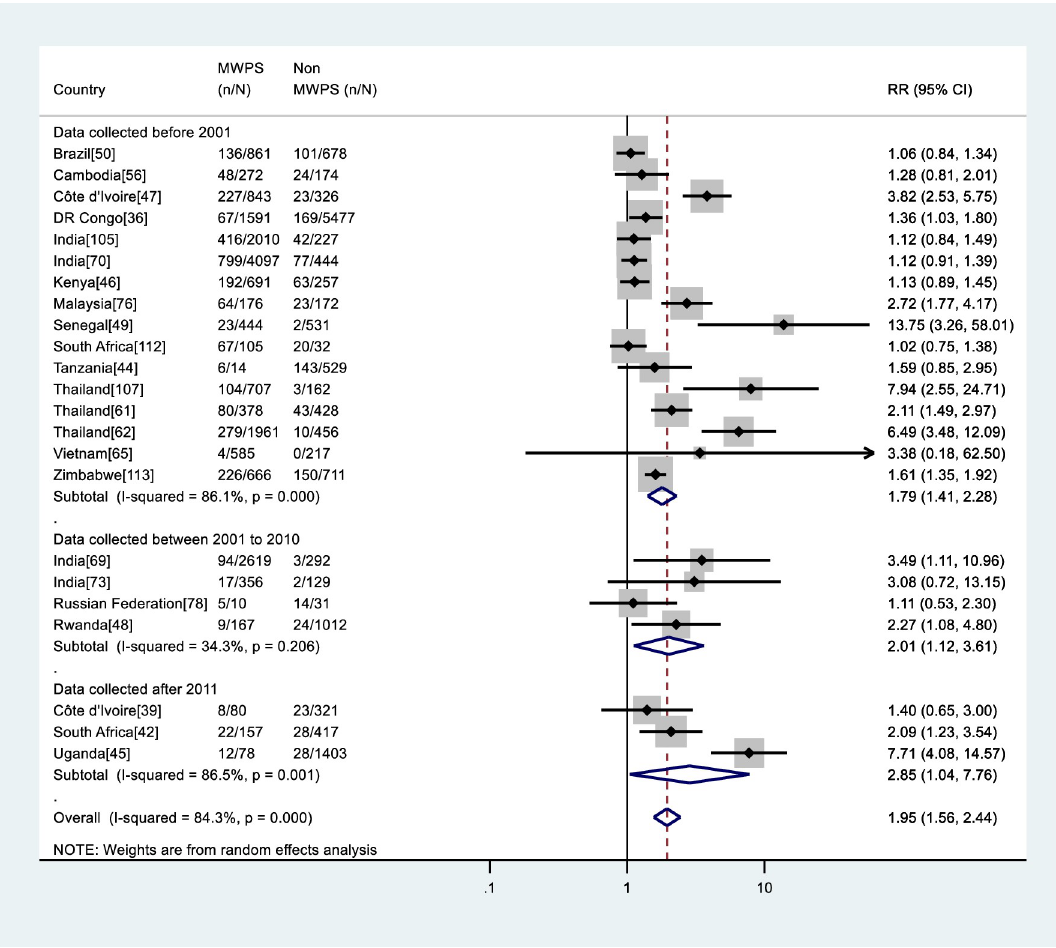
Fig 4. Meta-analysis of HIV risk in MWPS versus non-MWPS in LMICs by data collection period. RR: Relative risk, n: Number of HIV positive, N: Number of